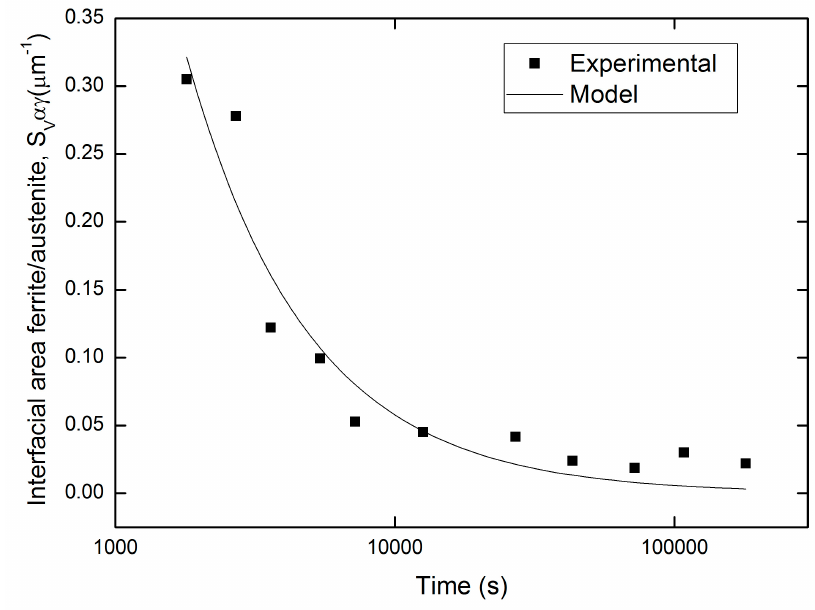
Figure 5. Interfacial ferrite–austenite ( S V αγ ) area as a function of the aging time, at 750 °C.